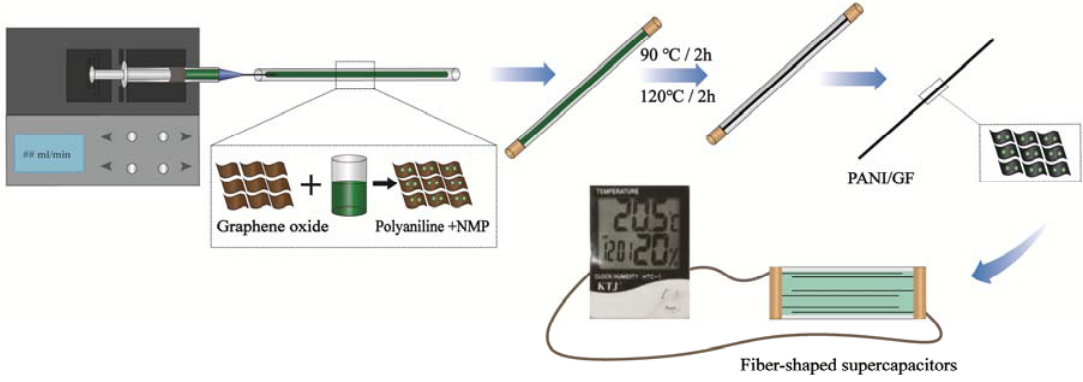
Figure 1. Schematic illustrations of the PANI/GF formation mechanism.